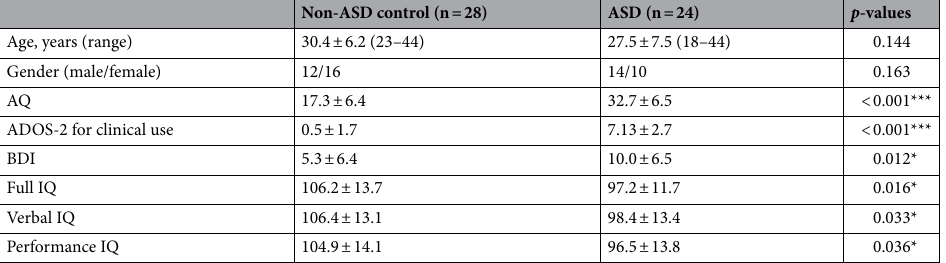
Table 1. The participant demographics. Data are mean ± SD. AQ autism spectrum quotient, ADOS-2 autism diagnostic observation schedule, 2nd edition, BDI Beck depression inventory, IQ intelligence quotient. * p < 0.05,** p < 0.01,*** p < 0.001 compared to the non-ASD controls (Student’s